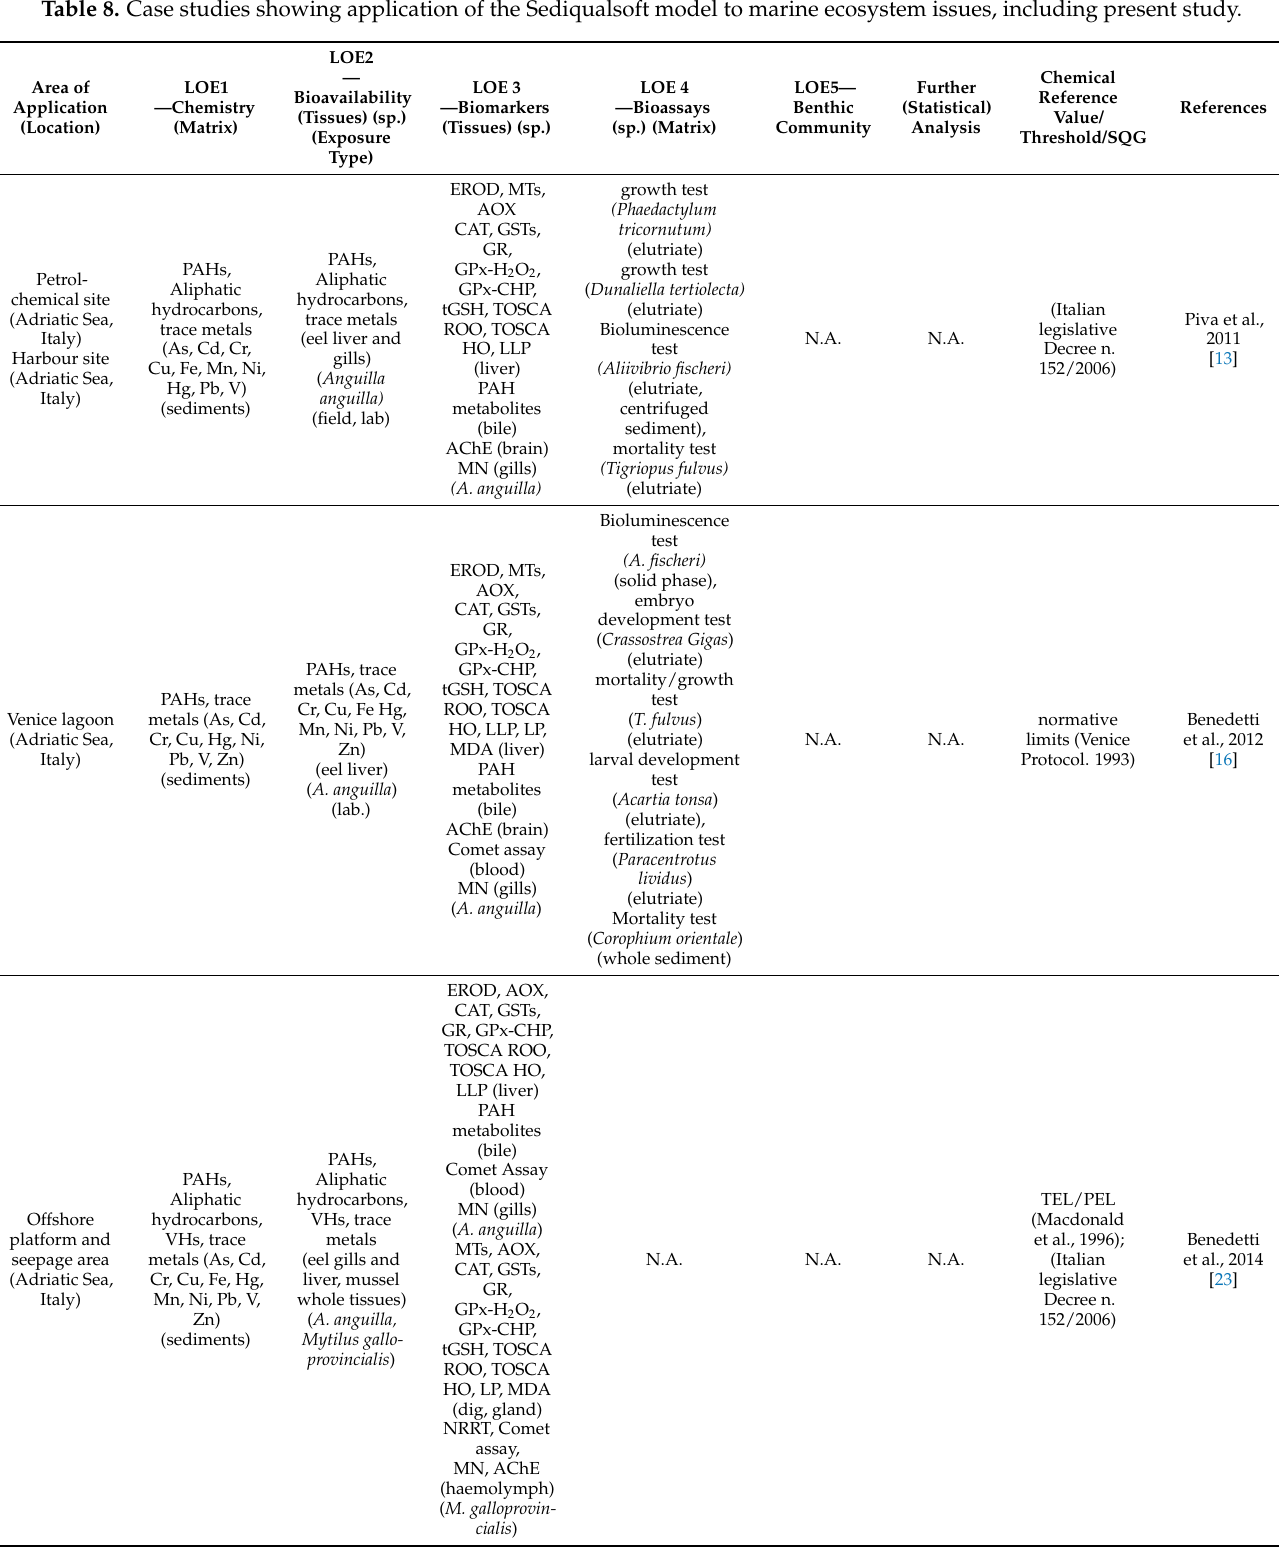
Table 8. Case studies showing application of the Sediqualsoft model to marine ecosystem issues, including present study.